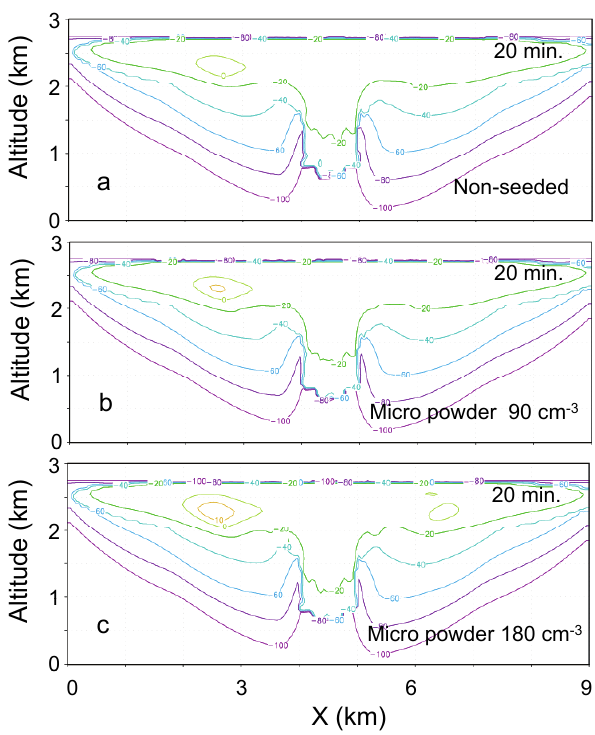
Fig. 14. Radar reflectivity in shallow convective cloud at 20min for the non-seeded case (a) and for seeded cases with salt micro- powder of different total number concentrations: 90cm − 3 (b) and 180cm − 3 (c)